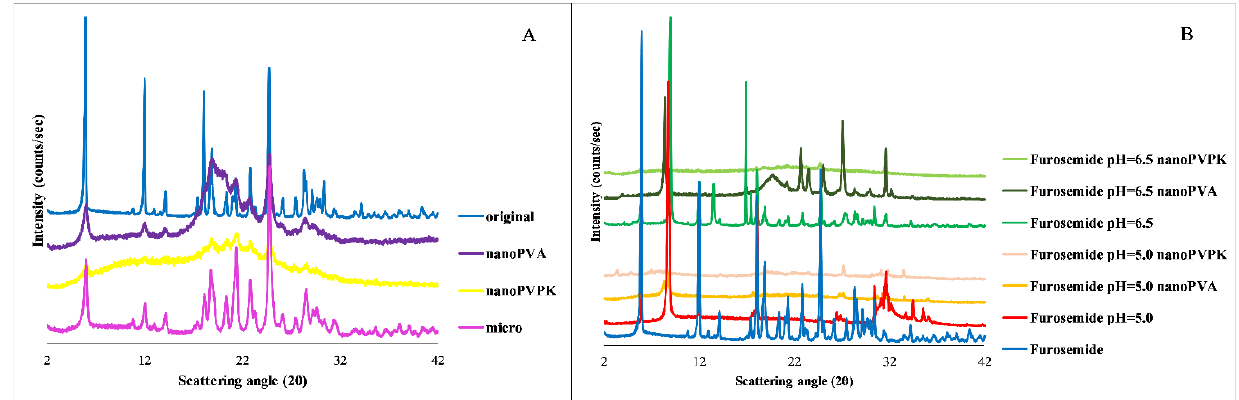
Figure 6. PXRD diffractogram of the original, micronized and nanonized furosemide ( A ) and the samples from the solubility measurements (pH = 6.5 and pH = 5.0) compared to the solid furosemide starting compound ( B ).